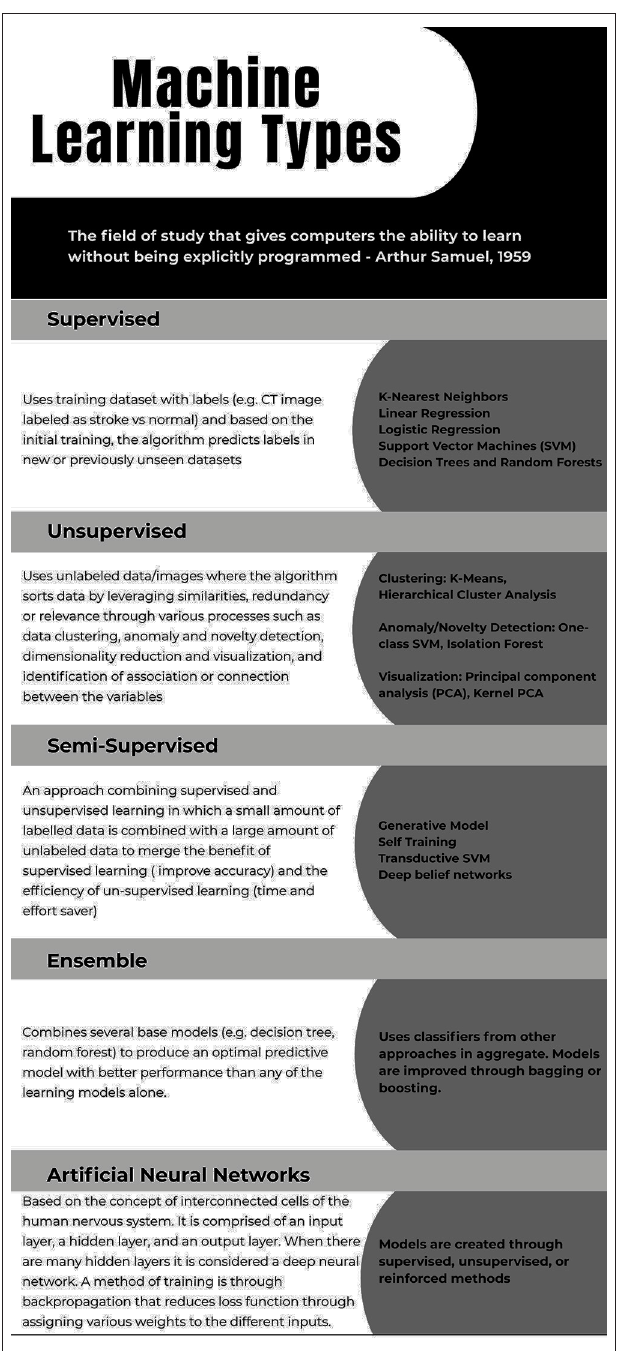
FIGURE 3 | Created from the following referenes: Dey (28) Zhou (29) Geron (30).